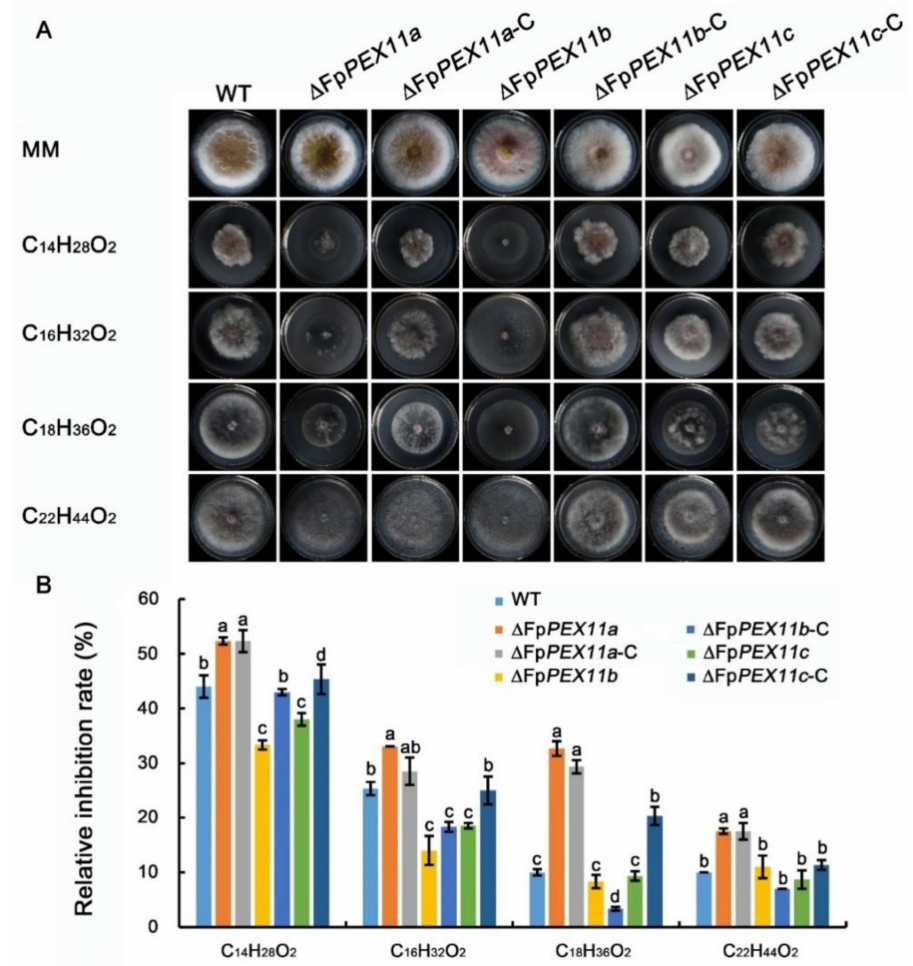
Figure 5. Deletion of strain affected fatty acid β -oxidation. ( A ) Strains were cultured at 25 ◦ C for 3 d on minimal medium (MM) supplemented with different carbon chain length of fatty acids as the sole carbon source. ( B ) Relative mycelial growth of WT and the mutants on various media. Different letter on the bars for each treatment indicate significant difference at p < 0.05 by Duncan’s multiple range